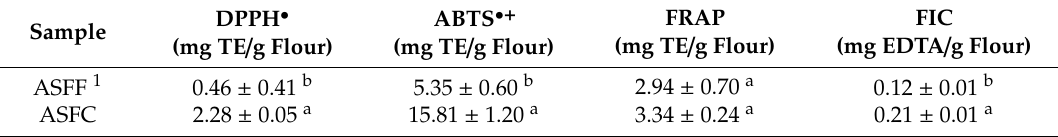
Table 5. Antioxidant properties of almond skin flours obtained from Turr ó n coproducts.